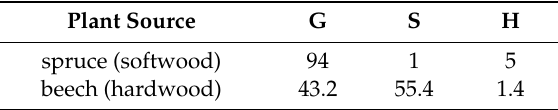
Table 1. Plant source and G:S:H ratio of selected organosolv lignin [37,38]. G—guaiacyl, S—syringyl, H—4-hydroxylphenyl groups found in different lignin